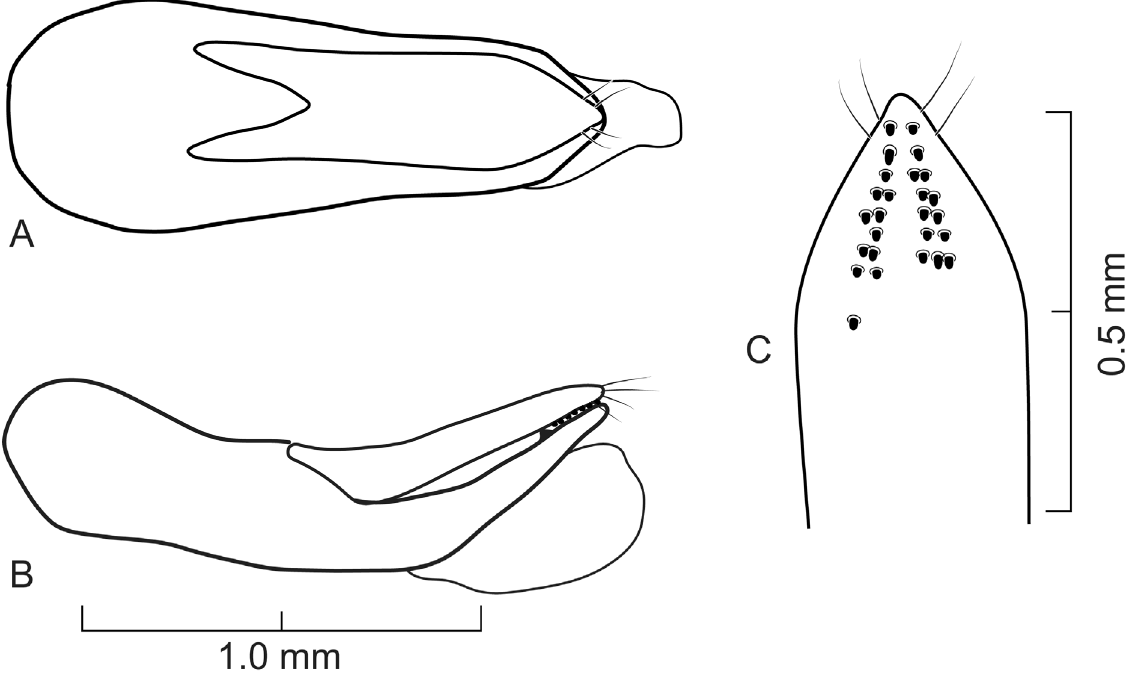
Fig. 4. Aedeagus of Ikaros paramo gen. et sp. nov. A . Dorsal view. B . Lateral view. C . Detail of paramere, ventral